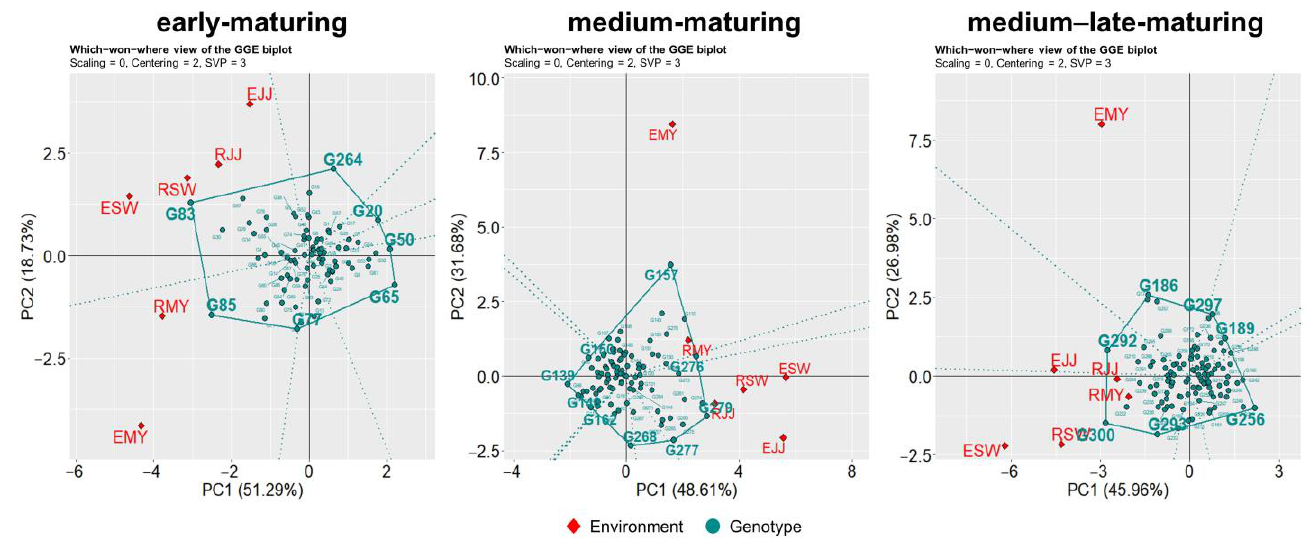
Figure 2. ‘Which-won-where’ polygon view of the GGE biplots for grain yield of early-, medium-, and medium–late-maturing cultivars in six environments. Red diamonds and green circles represent the environment and individual genotype, respectively. EJJ—early planting in Jeonju; RJJ—regular planting in Jeonju; ESW— early planting in Suwon; RSW—regular planting in Suwon; EMY—early planting in Miryang; RMY—regular planting in Miryang.